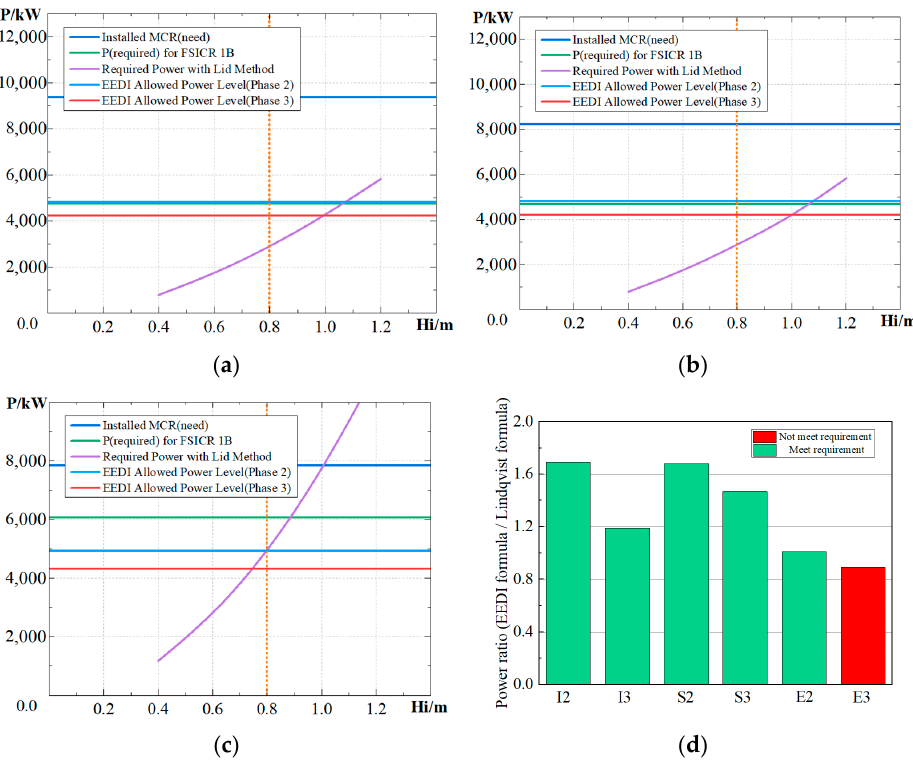
Figure 10. Power requirement results for 1B. ( a ) Power of traditional icebreaker bow, ( b ) Power of semi bow, ( c ) Power of EEDI type of bow form, ( d ) Power requirement comparison.